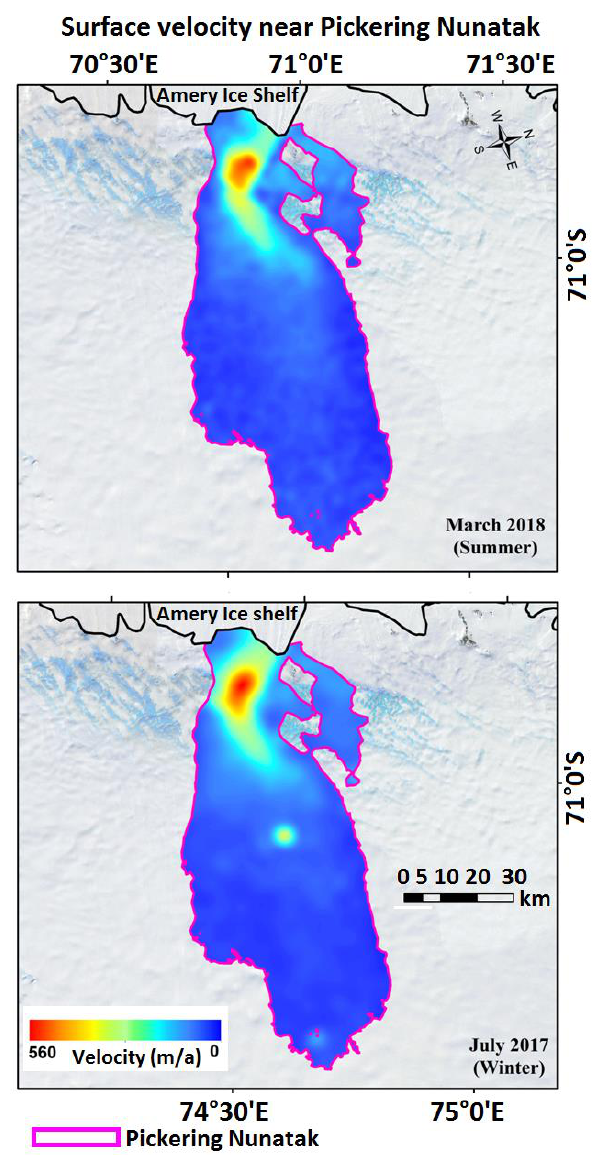
Figure 6. Summer and winter velocity near the